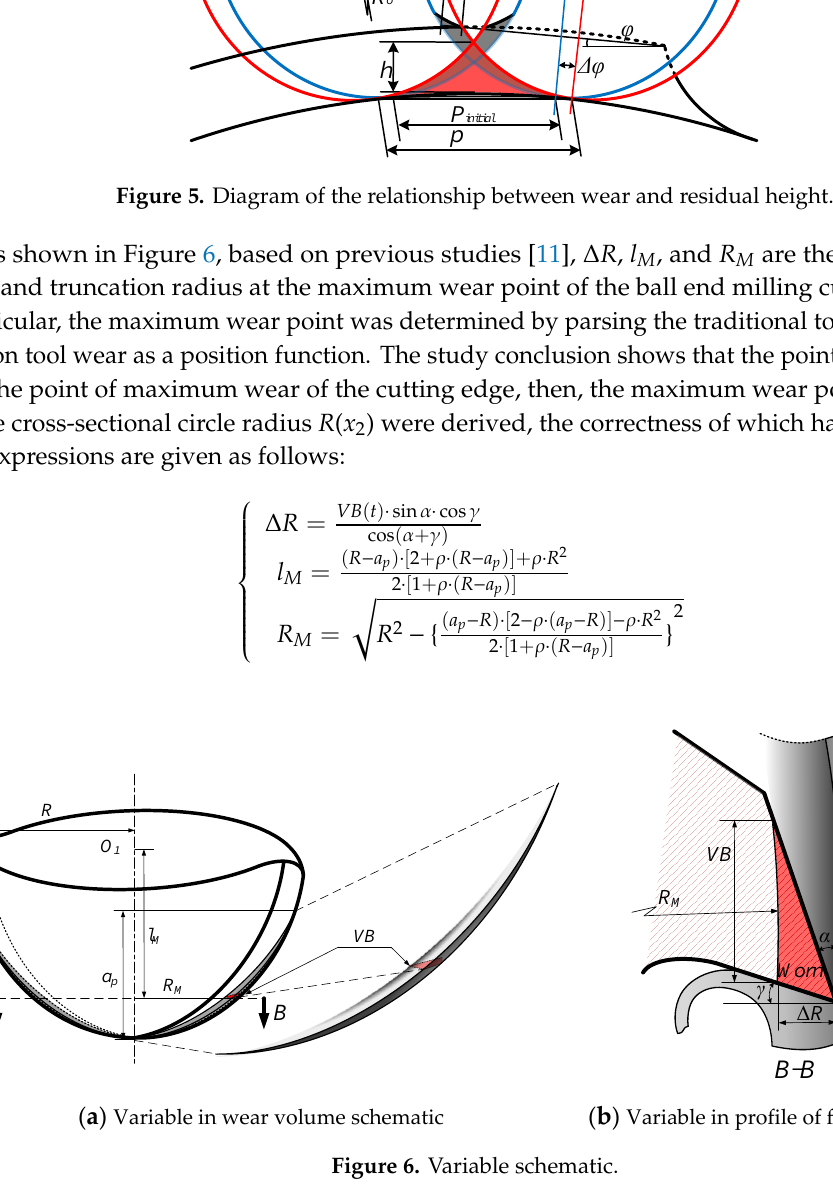
Figure 6. Variable schematic.